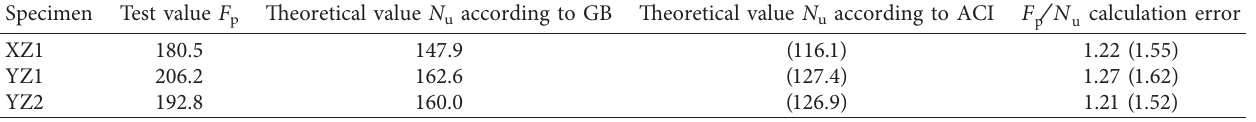
Table 7: Comparisons between test and theoretical bearing capacities (kN).